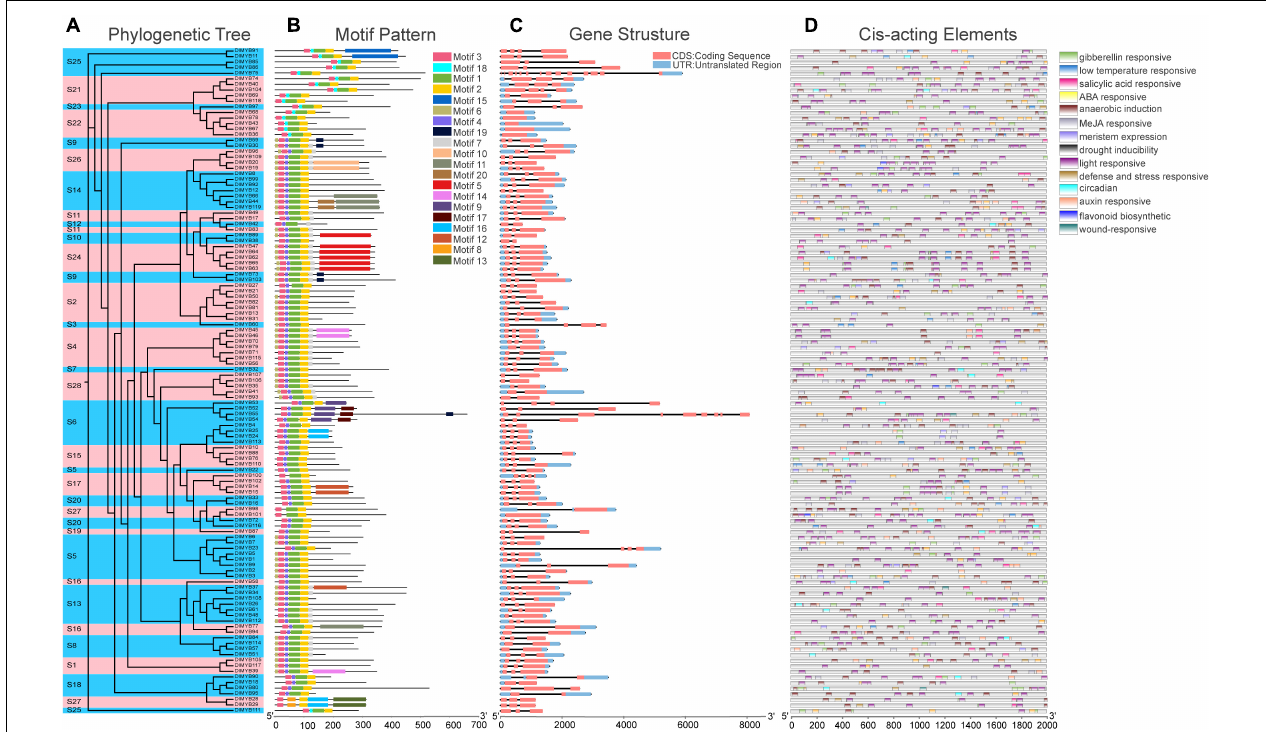
FIGURE 3 | Phylogenetic tree, conserved motifs, gene structural, and cis -acting element analysis of DlMYBs. (A) An Maximum Likelihood (ML) tree of 119 DlMYBs proteins with 1,000 bootstrap replicates. (B) The conserved motifs in DlMYBs were predicted using the MEME Suite web server. (C) Exon/intron structures of the longan R2R3-MYB genes. The introns, exons, and UTRs are indicated by orange boxes, black lines, and blue boxes, respectively. (D) The cis -acting elements of the longan R2R3MYB proteins were predicted using PlantCARE.